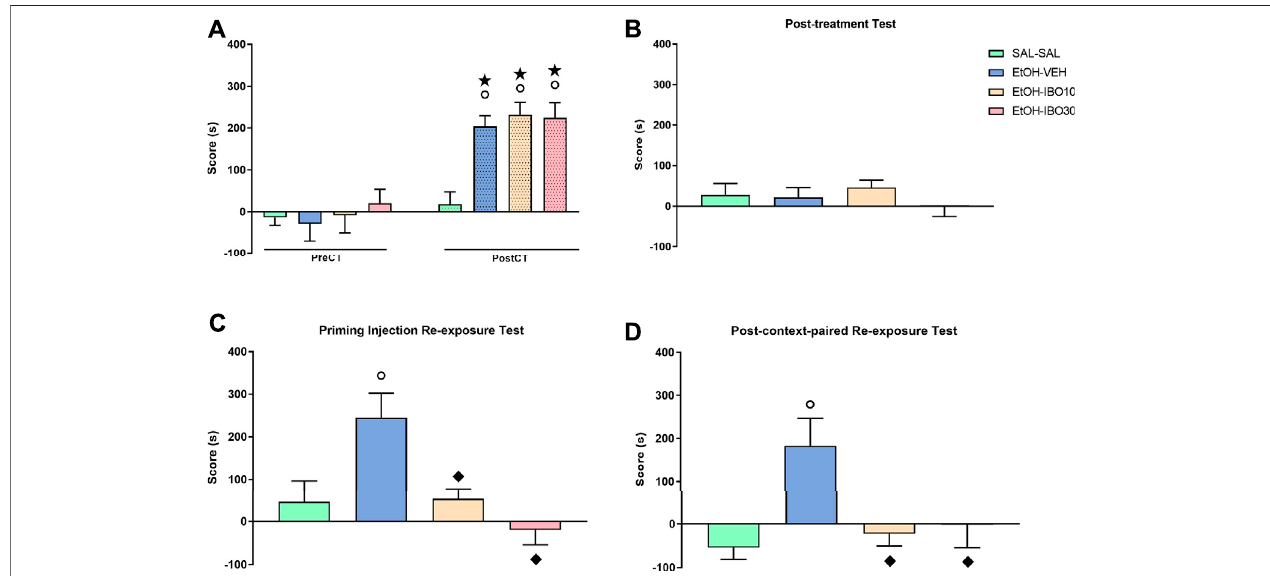
FIGURE4| Effectsoftreatmentwithibogaineonthereinstatementofethanol-induced conditionedplacepreference(CPP). (A) CPPscore(differencebetweenthe time spent in the ethanol- and in the saline-paired compartments) during the pre-conditioning test (preCT, n (cid:2) 24 per group) and the post-conditioning test (postCT, n (cid:2) 24 per group) following conditioning with saline (SAL, i. p.) or ethanol (EtOH, 1.8 g/kg, i. p.) in the CPP apparatus. (B) CPP score during a drug-free post-treatment test ( n (cid:2) 24pergroup)aftertreatmentwithsaline(SAL,i.p.),vehicle(VEH,oraladministration)oribogaine(IBO,10or30 mg/kg,oraladministration)intheethanol-paired compartment. (C) CPP score during a priming injection re-exposure test in which all groups received a priming injection of ethanol (EtOH, 1.8 g/kg, i. p.) and had free access to theCPP apparatus ( n (cid:2) 8 per group). (D) CPP score during adrug-freetest conducted24 hafter acontext-paired re-exposure, in which subjects received an injection of saline (SAL-SAL group, n (cid:2) 16) or ethanol (EtOH, 1.8 g/kg, remaining groups, n (cid:2) 16 per group) and were con fi ned to the compartment previously conditionedtoethanol.Dataarereportedasmeans ± SEM. + p < 0.05comparedwiththesamegroupinthePreCT; ° p < 0.05comparedwiththeSALgroupinthesame experimental phase; p < 0.05 compared with the EtOH group in the same experimental